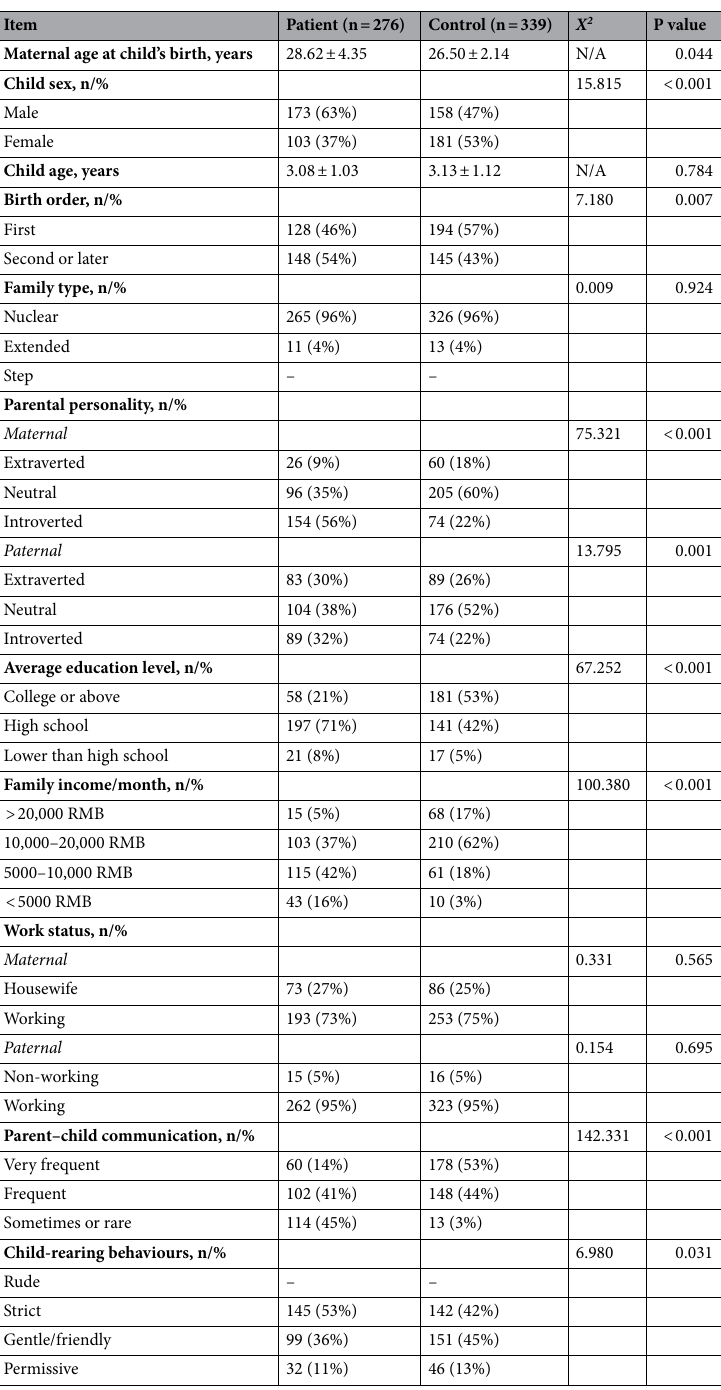
Table 1. Univariable analysis of the potential familial risk factors for developmental speech delay in children. N/A, not applicable because the t test was performed. – means